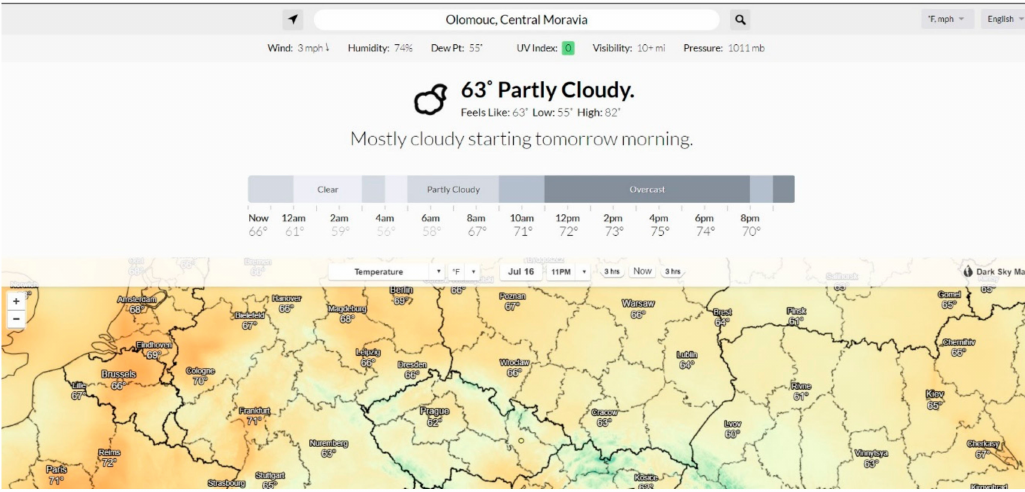
Figure 1. DarkSky map preview. The map has a simple composition, highlighting the basic information based on the location that is in the top field. The sample map in the preview is presenting temperatures. Area patterns combined with the isoline method are implemented in this map. One thematic layer also o ff ers emoticons in the point method. The map does not contain a legend. Methods are used correctly; nevertheless, a legend is missing. The application’s design is simple and easy to